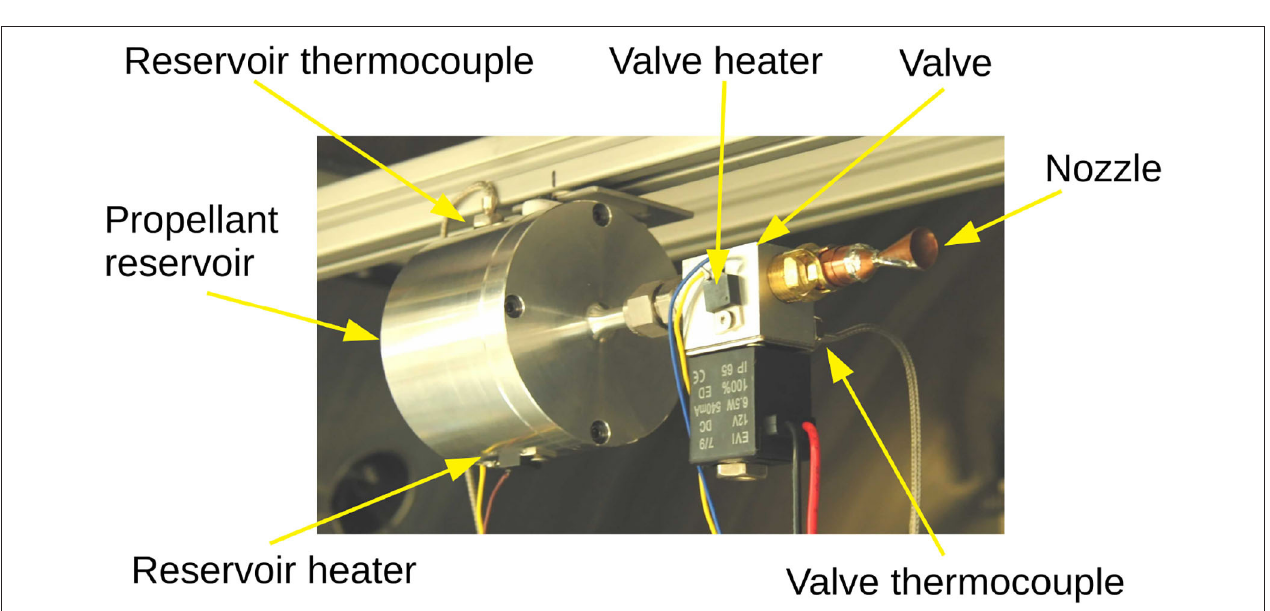
FIGURE 2 | Diagram of the naphthalene thruster with its main components highlighted. The reservoir temperature T r is measured by the reservoir T/C and controlled by the reservoir heater resistor; the valve temperature T v is measured by the valve T/C and controlled by the valve heater resistor.